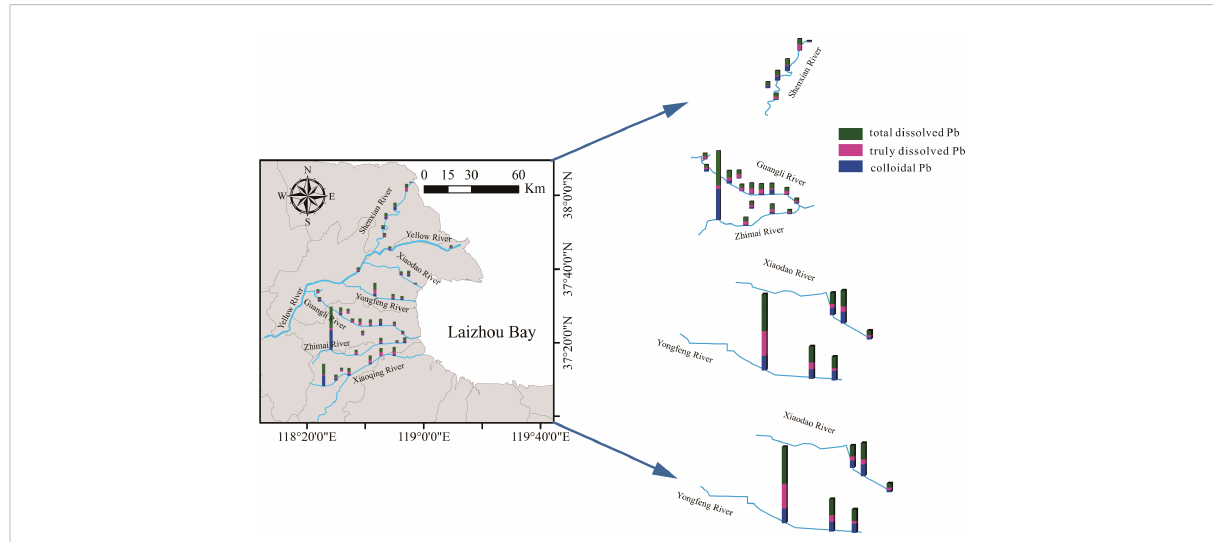
FIGURE 4 The distribution of total dissolved lead (Pb), truly dissolved Pb, and colloidal Pb in different seaward